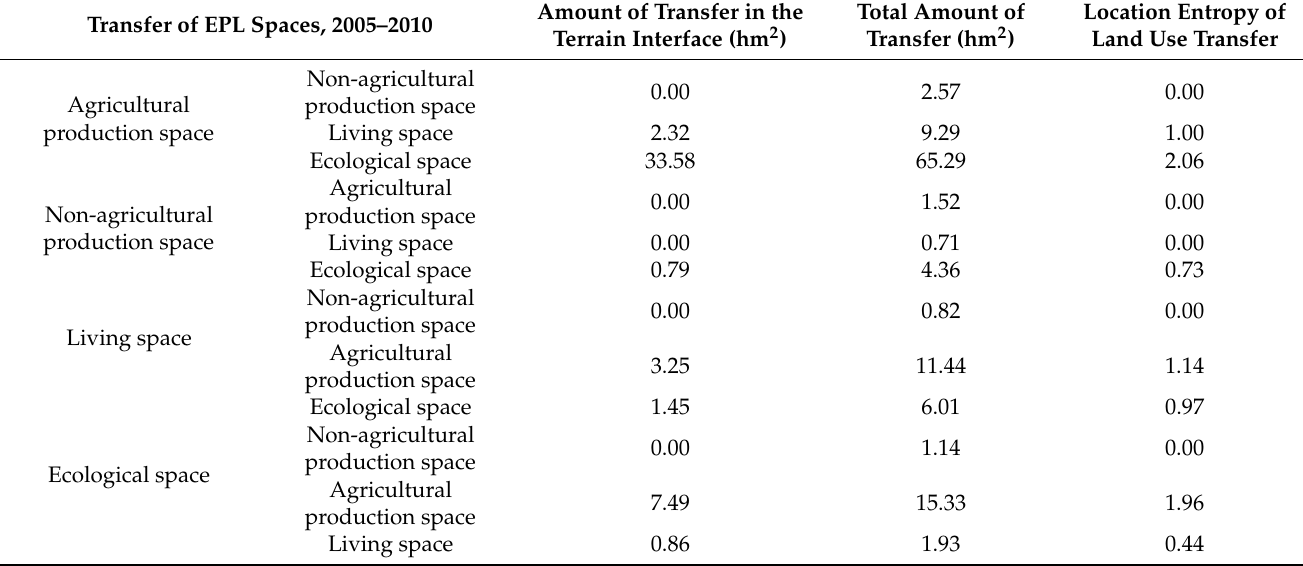
Table 6. Spatial transfer of EPL spaces in the terrain interface area from 2005 to 2010.